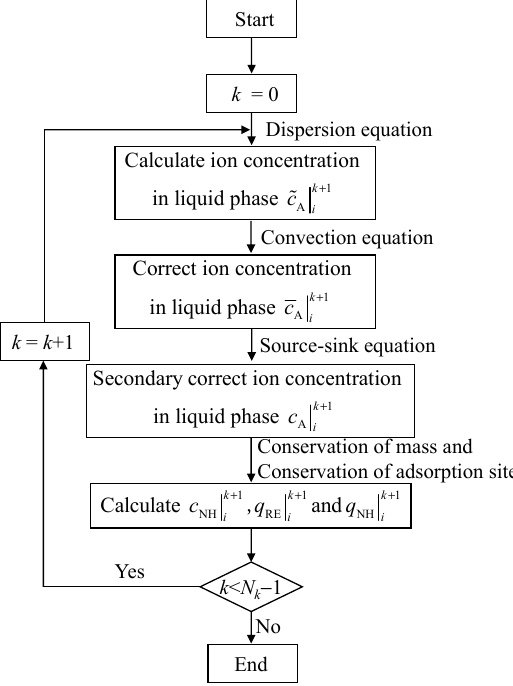
Figure 4. Flow chart of the decoupling